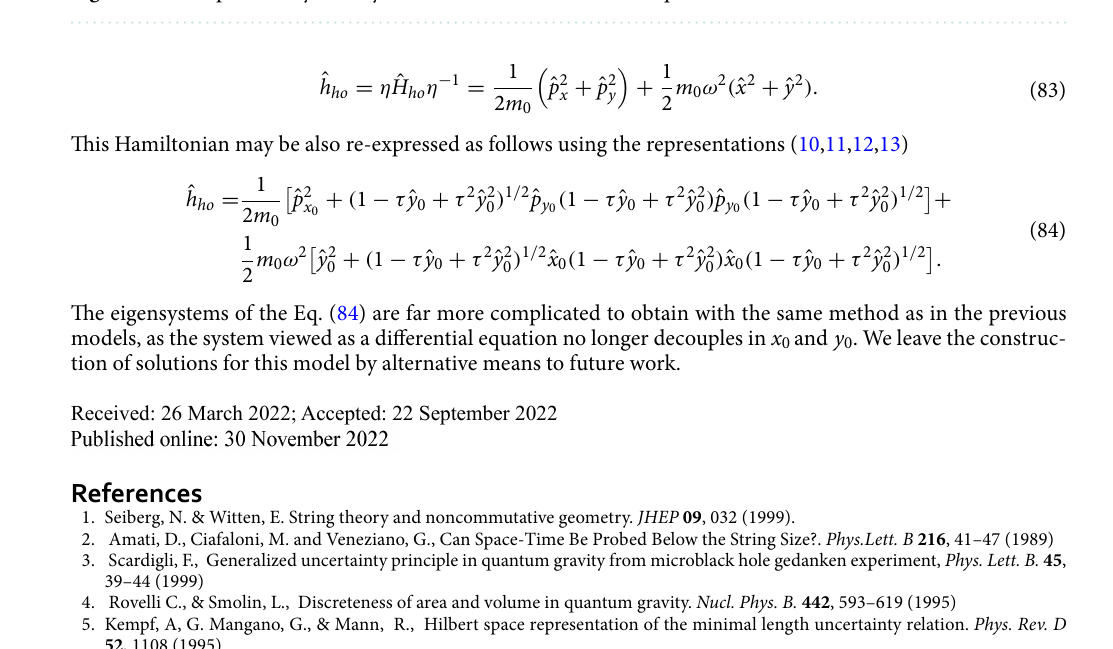
Figure 10. The probability density of a two-dimensional infinite square well for τ